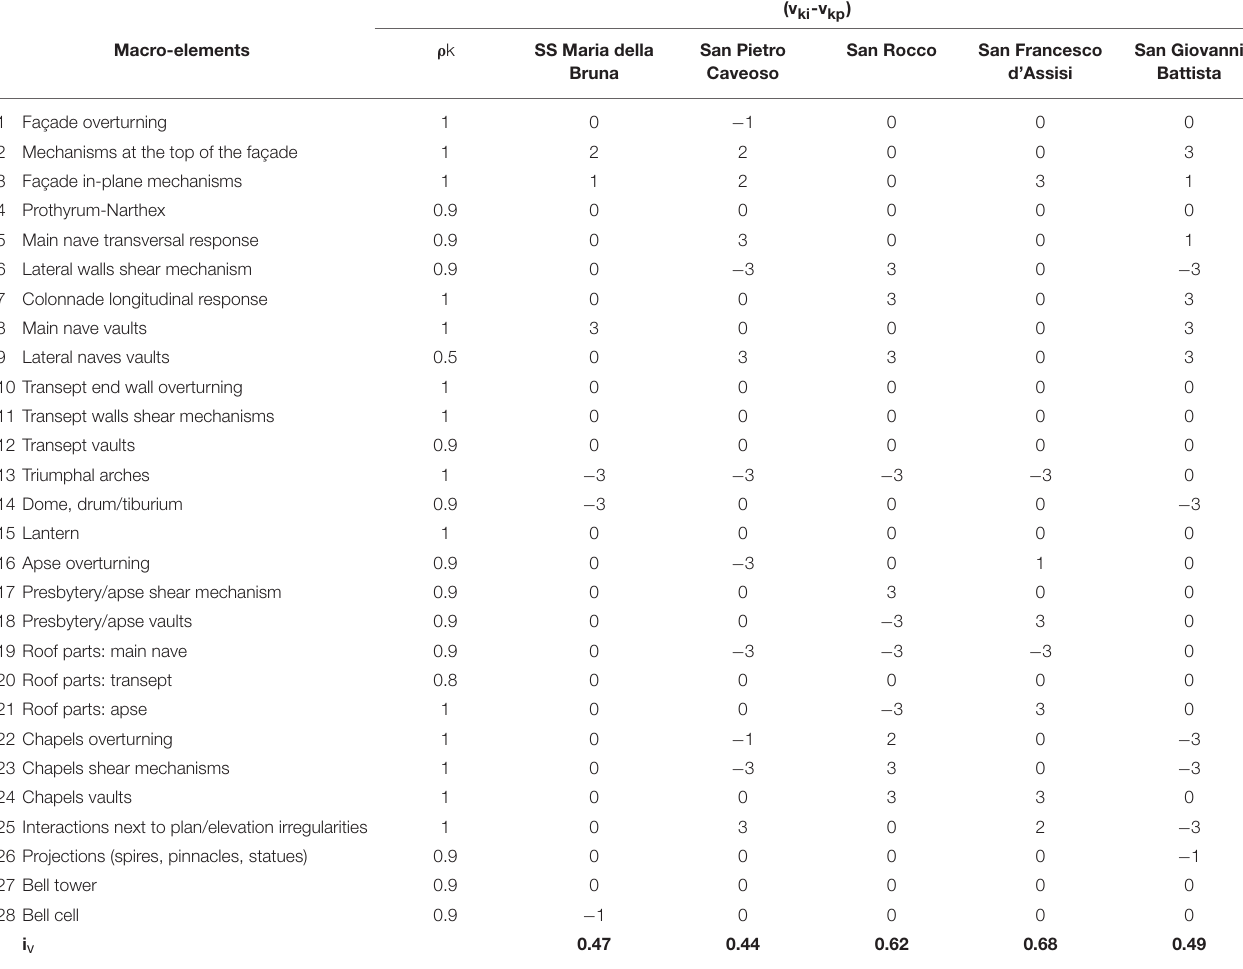
TABLE 2 | Scores obtained by applying the LV1